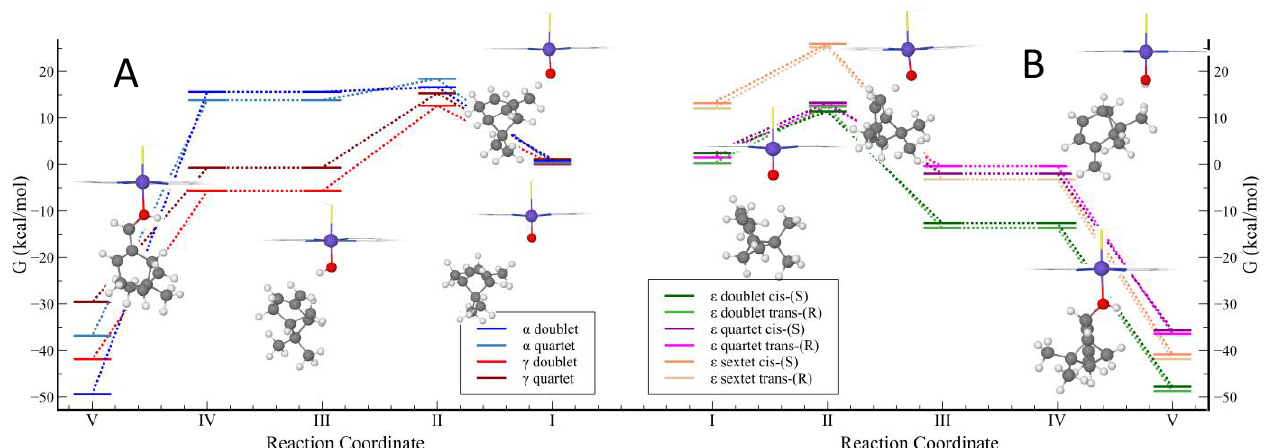
Figure 7. Reaction coordinates for the Gibbs free energies from the hydrogen abstraction and rebound mechanism of the α -pinene catalyzed by the CYP enzyme; ( A ) alpha and gamma, and ( B ) epsilon. Data are provided in kcal/mol and relative to the gamma site reactant, the most stable structure in coordinate 1. Optimized structures for the gamma doublet path in the left and epsilon cis-(S) doublet path in the right.